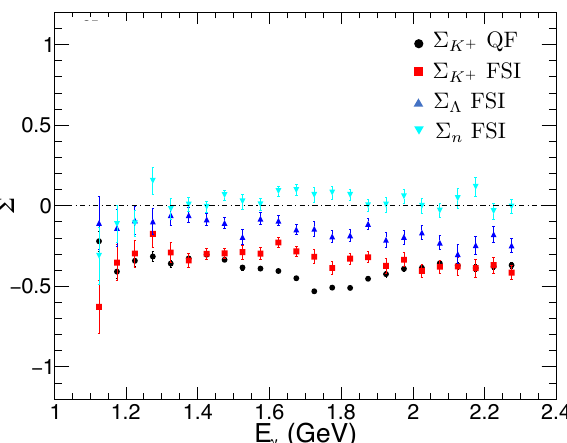
Figure 6: Beam spin asymmetries as a function of the photon energy of real data. The different points show the asymmetries determined using the azimuthal distribution of the various particles as indicated in the caption. Specifically, the black points show the beam-spin asymmetry of kaons using a QF-dominated sample ( P where as the red blue and cyan points show the beam-spin asymmetries determined using the kaon, hyperon, and neutron azimuthal distribution of an FSI-dominated > 200 MeV / data sample ( P x